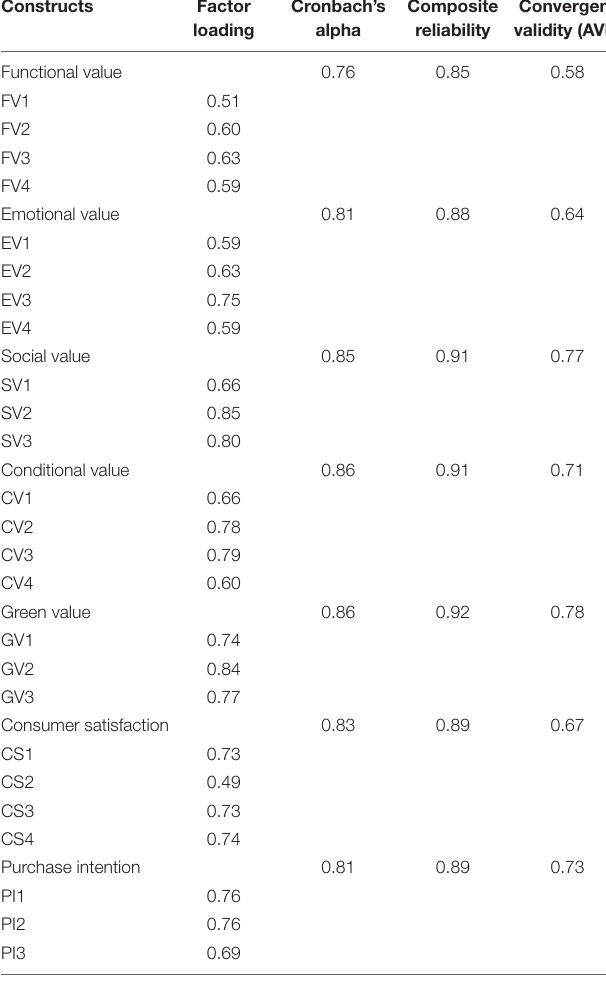
TABLE 3 | Reliability and validity analysis.